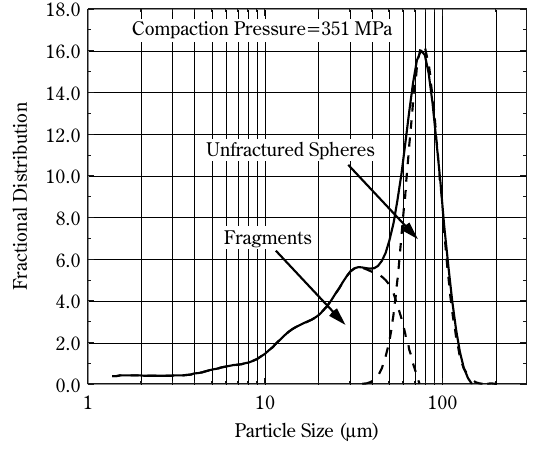
Fig. 7 Bimodal size distribution of compacted glass spheres.